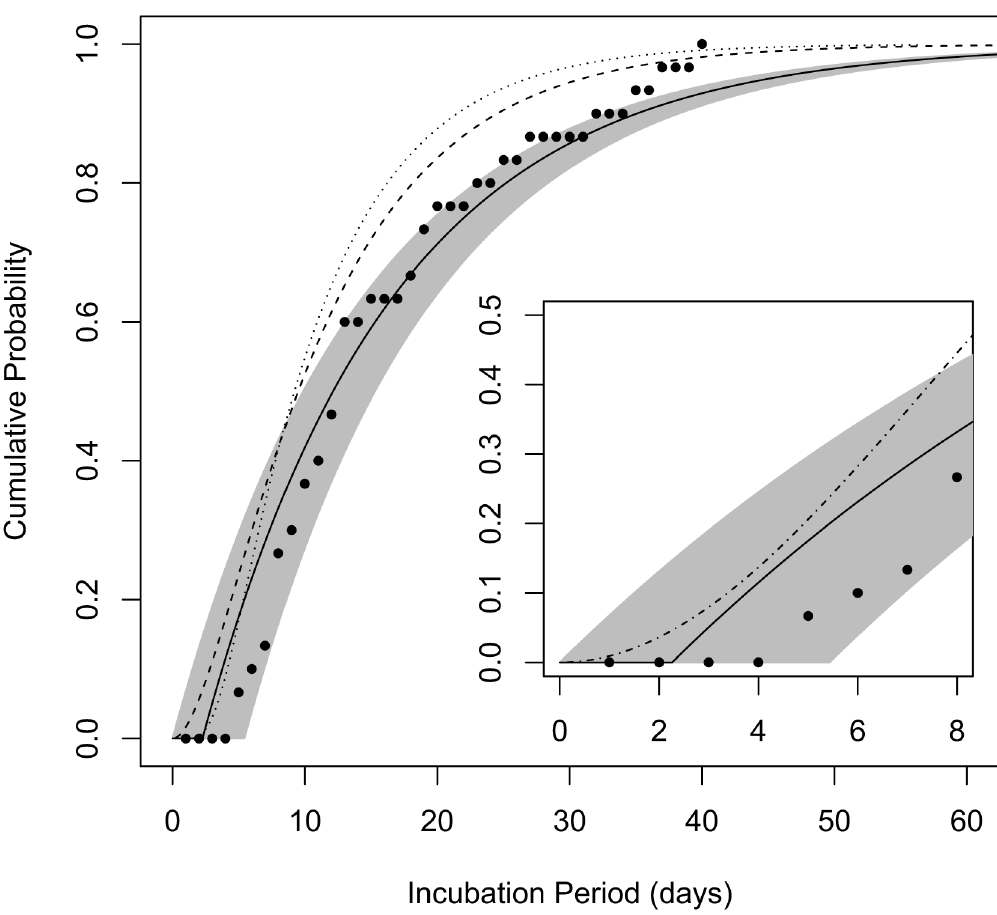
Figure 4. Cumulative distribution functions for the incubation period among those infected by a low dose. The curves show the probability that a given incubation period (time from exposure to symptoms) among those infected by the ID 1 would be less than the given number of days post-exposure. Solid line represents the estimate produced by model B4 and the shaded area spans the 95% confidence bounds; dashed line is the curve produced by the model of Brookmeyer et al. [32]; dotted line is the curve produced by the model of Wilkening [37]; points are data from 30 autopsy-confirmed anthrax cases after the Sverdlovsk release [36]. Inset: comparison of our model B4 with the model proposed for use by the IOM [12] for the anthrax incubation period distribution over the first 8 days after exposure (dash-dotted